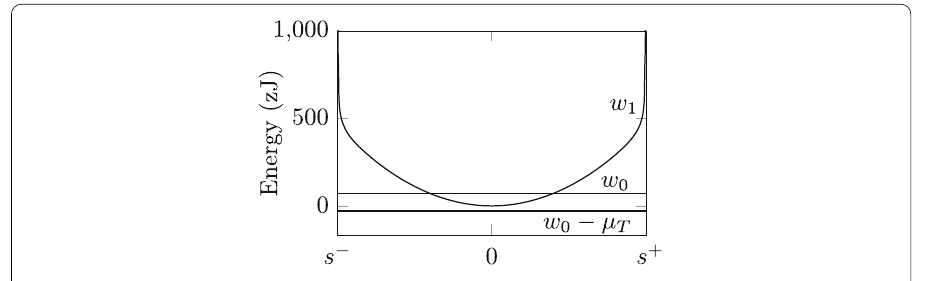
Fig. 6 Energy levels parametrization for the Huxley’57 model